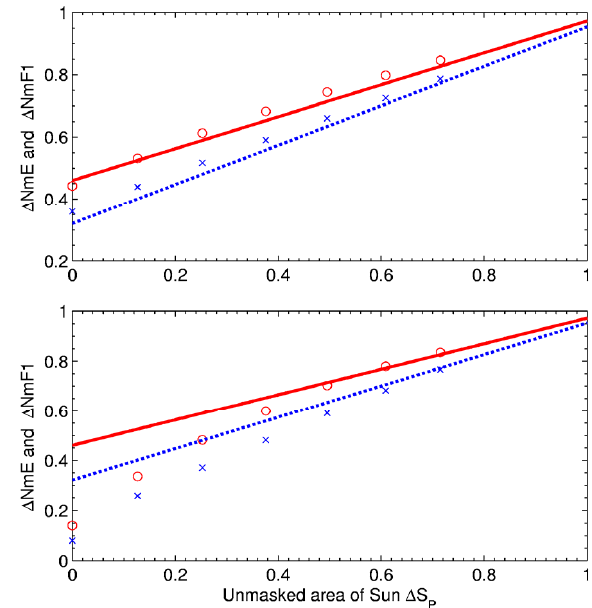
Figure 3. Comparison of linear fit for the observed Δ NmE (solid line) and Δ NmF1 (dotted line) 572 Fig. 3. Comparison of linear fit for the observed 1 NmE (solid line) which is the same as Figure 2 with the modelled Δ NmE (circles) and Δ NmF1 (crosses) by using 573 and 1 NmF1 (dotted line) which is the same as Fig. 2 with the mod- elled 1 NmE (circles) and 1 NmF1 (crosses) by using the revised the revised eclipse factor F R (Top) and the unrevised eclipse factor F (Bottom), respectively. 574 eclipse factor F R (Top) and the unrevised eclipse factor F (Bottom),